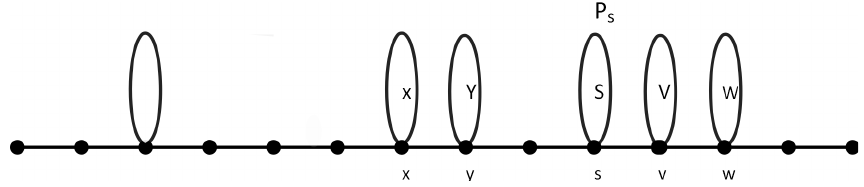
Figure 7: A tree of odd diameter with central edge 𝑥𝑦